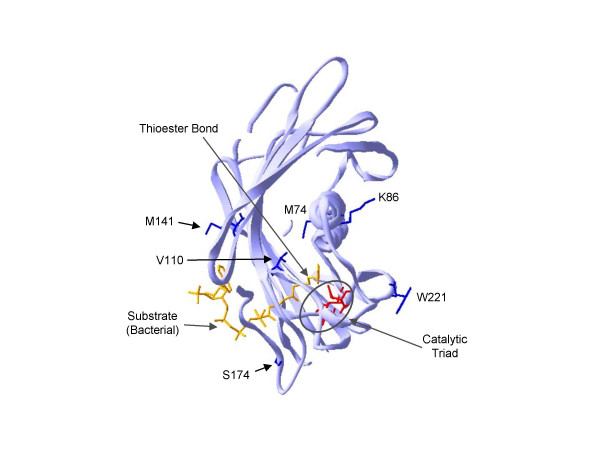
3D structural model of the AtFatB enzyme [11]. The CPDL-identified residues are shown in blue. The catalytic triad is circled with the residues colored red. The substrate from the bacterial enzyme is shown in orange for reference.